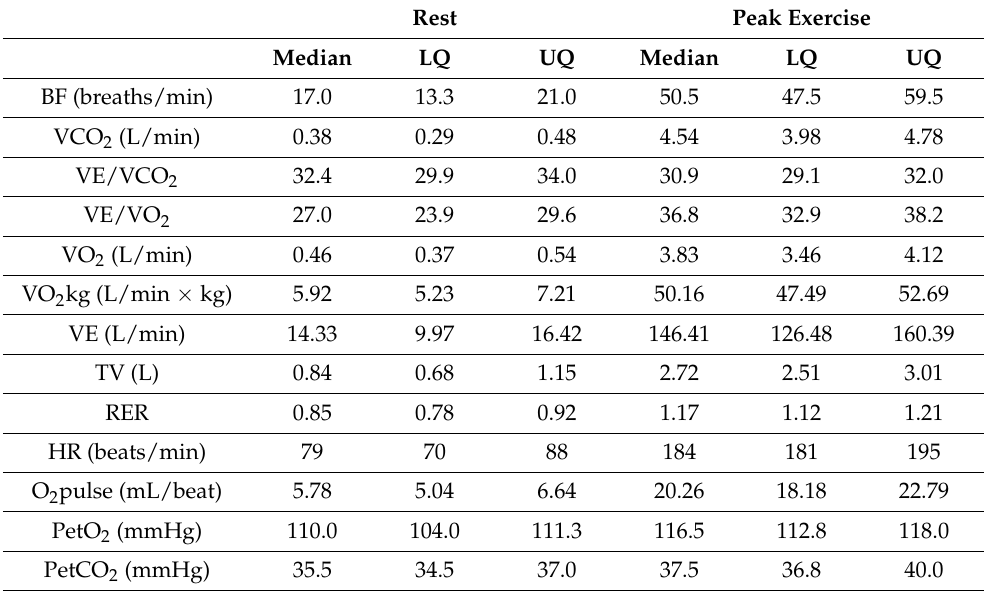
Table 2. Summary baseline characteristics of CPET parameters at rest and peak exercise.